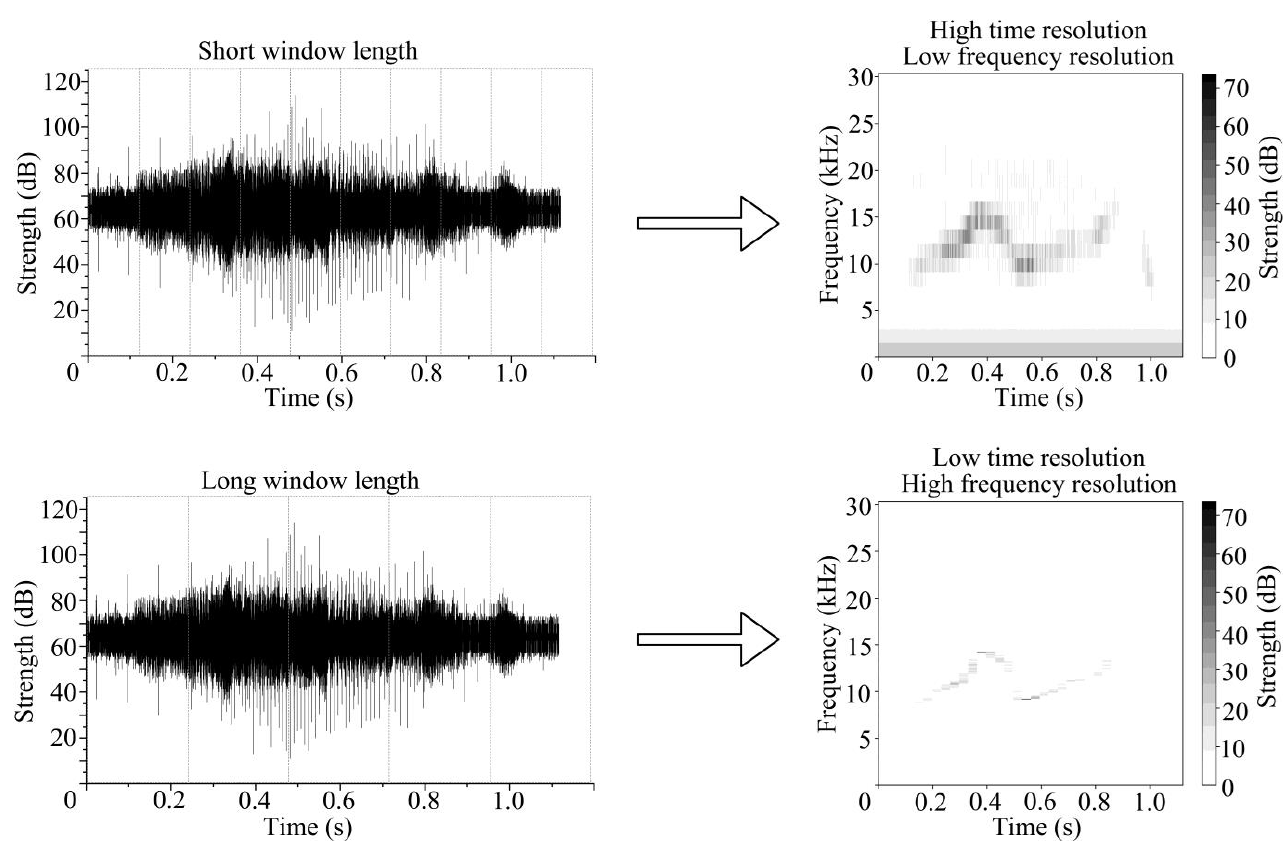
Figure 2. Uncertainty principle in time–frequency analysis.